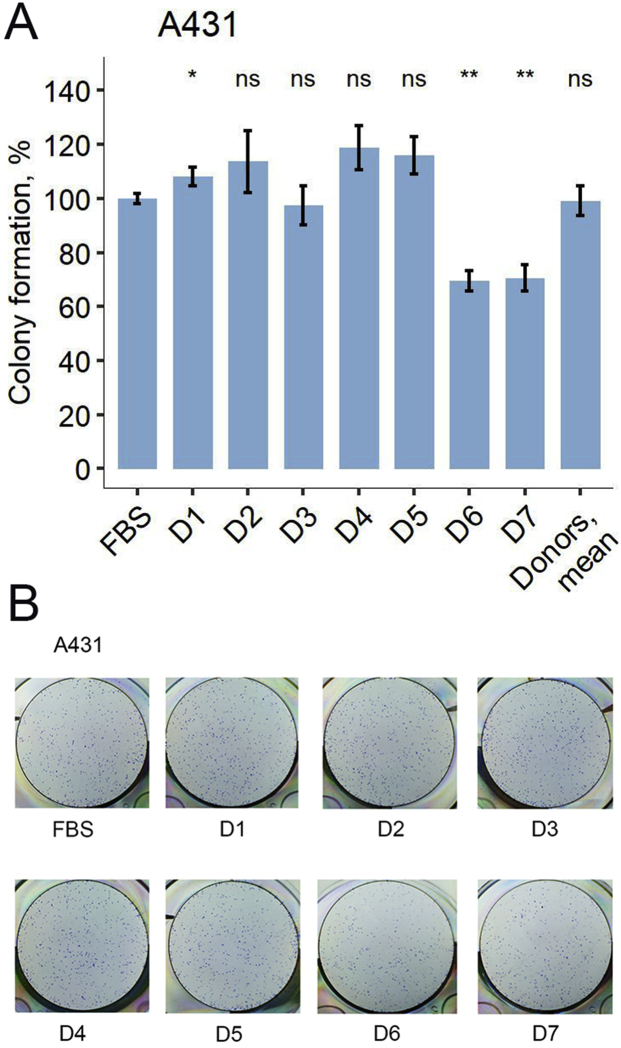
Colony formation by A431 cells in the growth media containing 10% FBS supplemented with human blood serum samples. (A) Colony formation is normalized to the FBS-only growth media (column FBS). The average of seven human donor serum samples is indicated as « mean » Asterisks indicate the significance of the difference from FBS-only experimental results. (B) Representative photographs of stained clonogenicity assay results were used for colony number calculations.